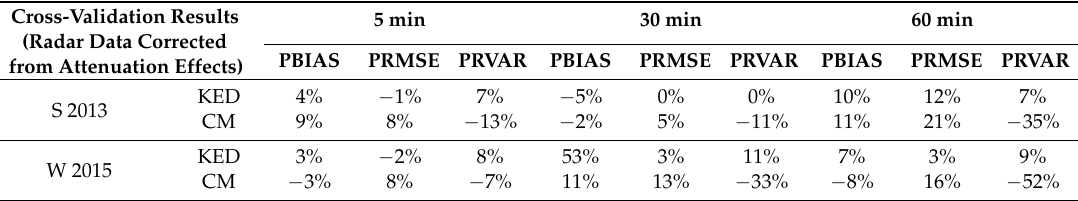
Table 9. The relative improvement in interpolation Performance metrics results for KED and CM when radar data is corrected from attenuation